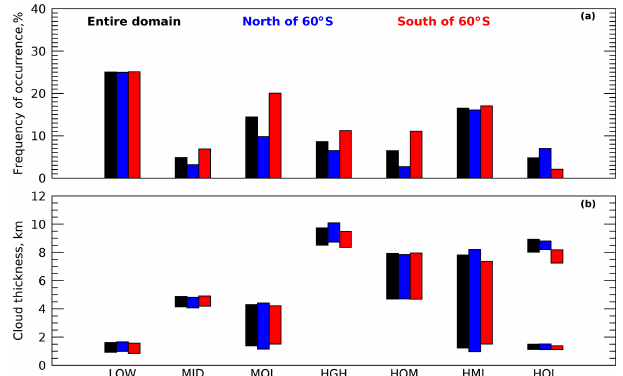
Figure 4. (a) Cloud liquid water paths (LWPs) retrieved from mi- crowave radiometer (MWR) measured brightness temperatures us- ing a physical retrieval method for each type of cloud. (b) The oc- currence frequencies of LWPs > 10gm − 2 for each type of